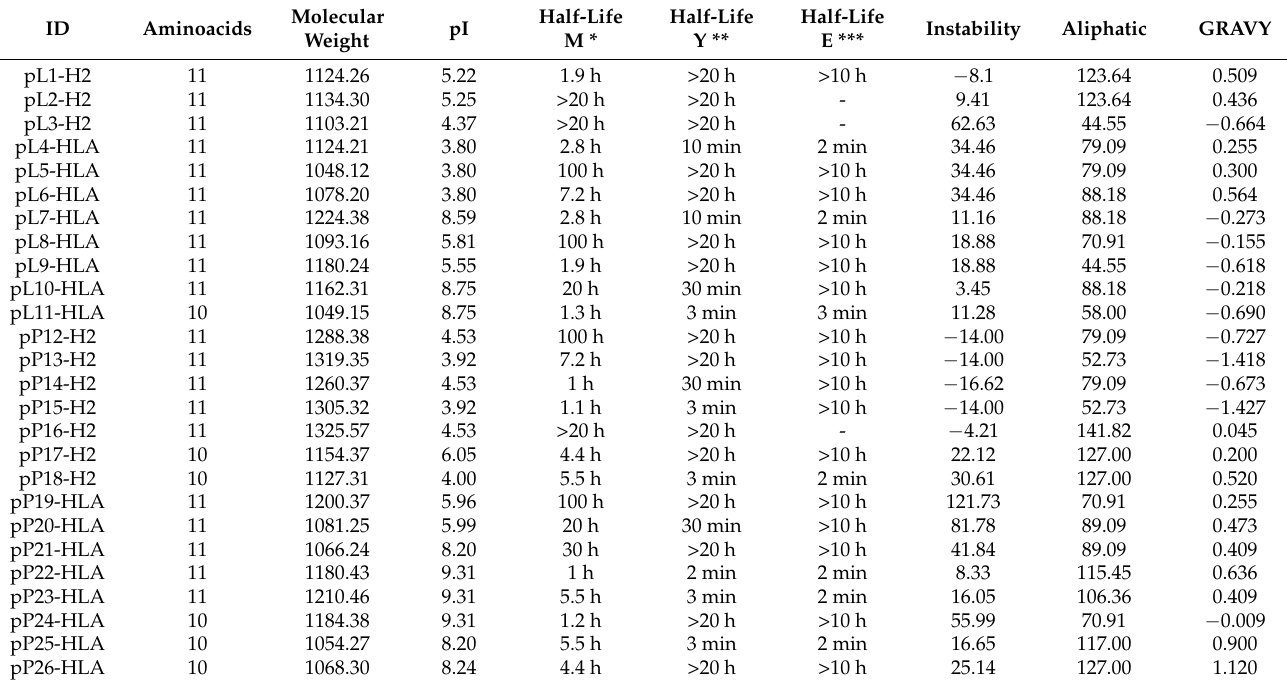
Table 2. Physicochemical parameters of